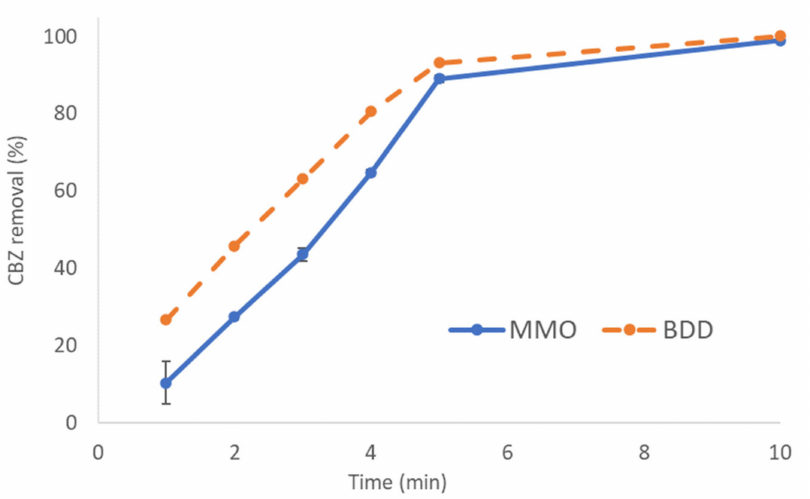
Figure 1. Effect of the anode material on CBZ removal in aqueous solutions (operational conditions: current density = 6.67 mA/cm 2 ; inter-electrode distance = 3.5 cm; NaCl = 0.1 M; CBZi = 10 mg/L; pH = 5; reaction time = 10 min; cathode =